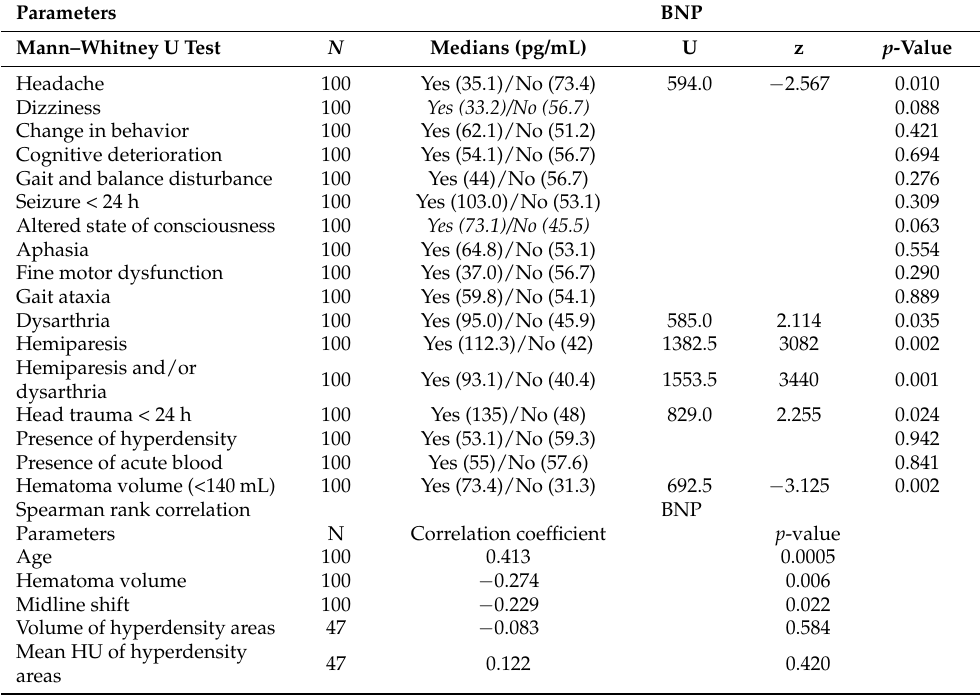
Table 3. Relationship between BNP and clinical and radiographic parameters.